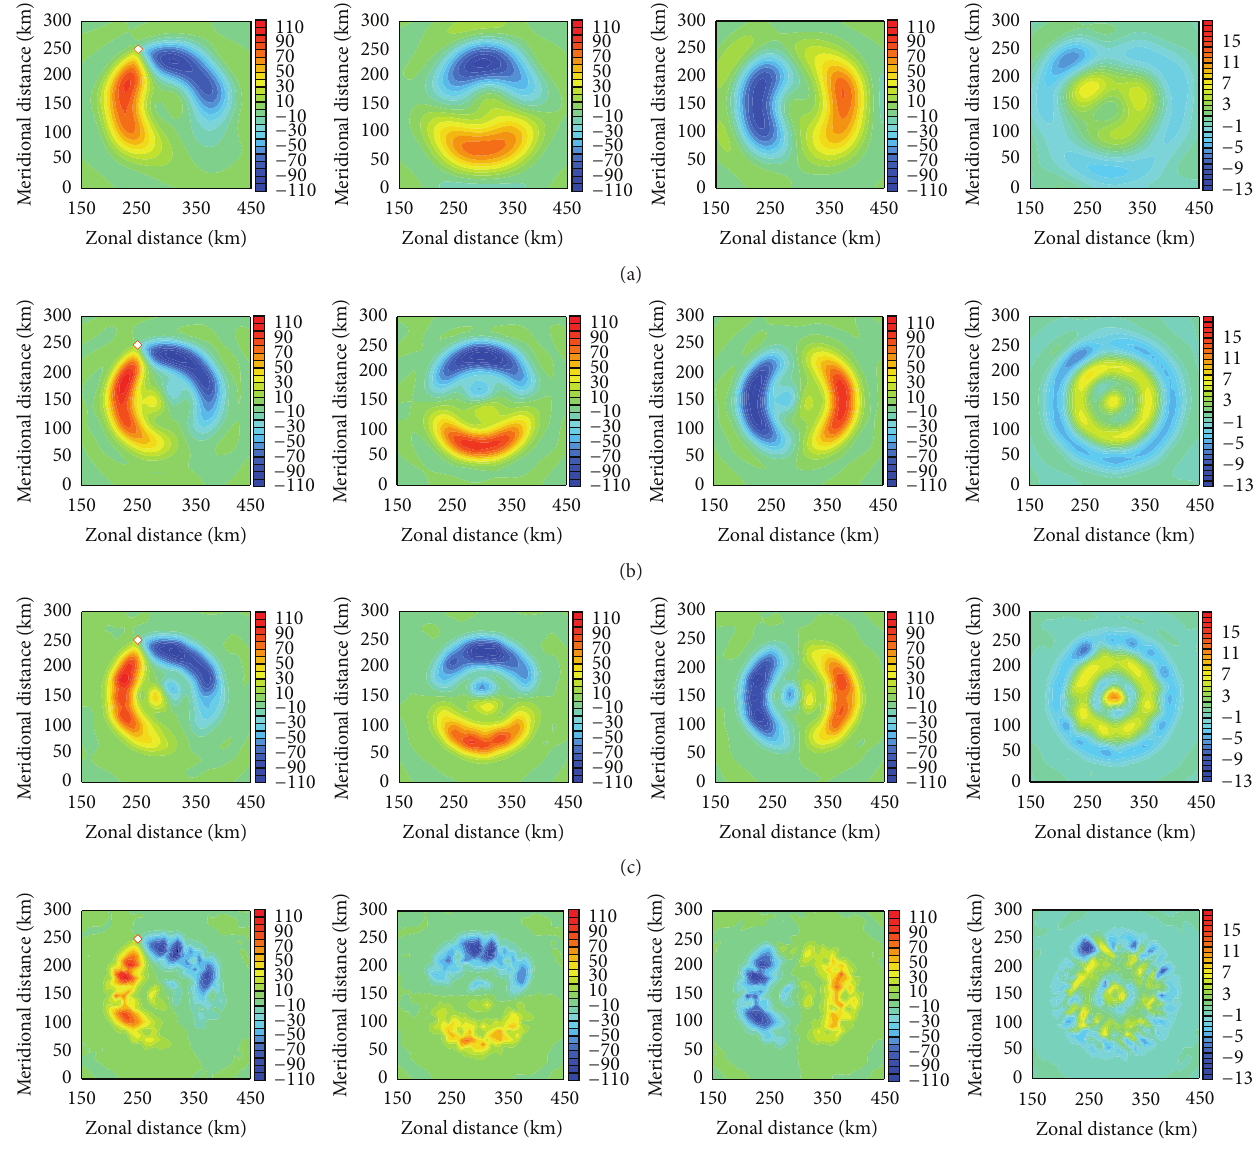
Figure 5: Similar to Figure 4(b) but with the results of traditional 3D-Var with correlation scales being 𝐿 𝑥 = 50 km, 𝐿 𝑦 = 50 km, and = 5 km (a); 𝐿 𝐿 𝑧 = 6.25 km, and 𝐿 𝐿 𝑦